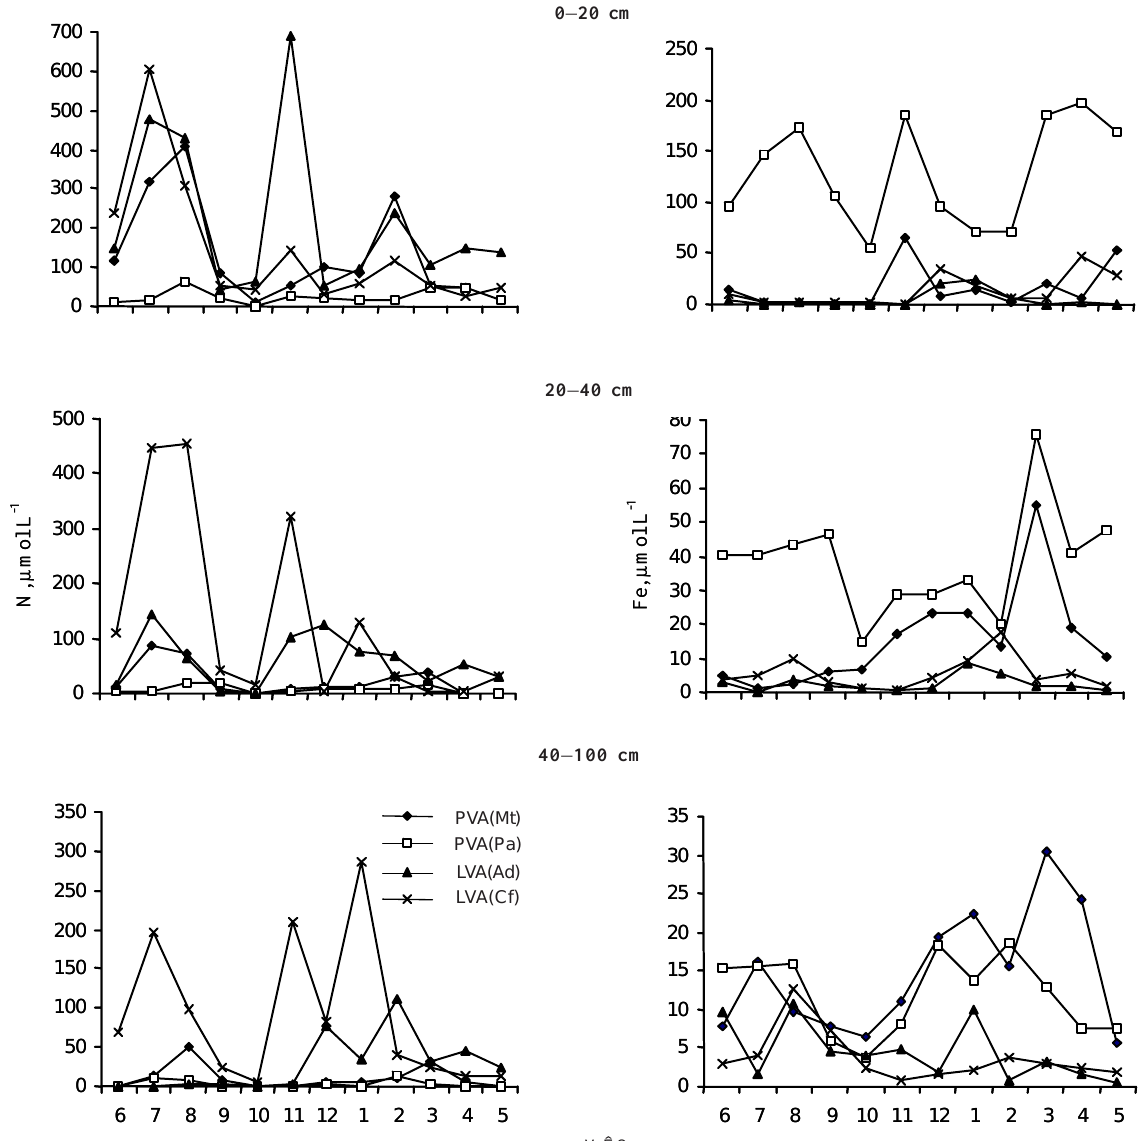
Figura 5. Variação mensal da concentração de nitrogênio nítrico e de ferro na solução do Argissolo Câmbico sob mata (PVA(Mt)) e sob pastagem (PVA(Pa)) e do Latossolo Vermelho-Amarelo sem cobertura vegetal (LVA(Ad)) e sob cafeeiro (LVA(Cf)), no período de junho de 1996 a maio de 1997, em três profundidades. Média de três